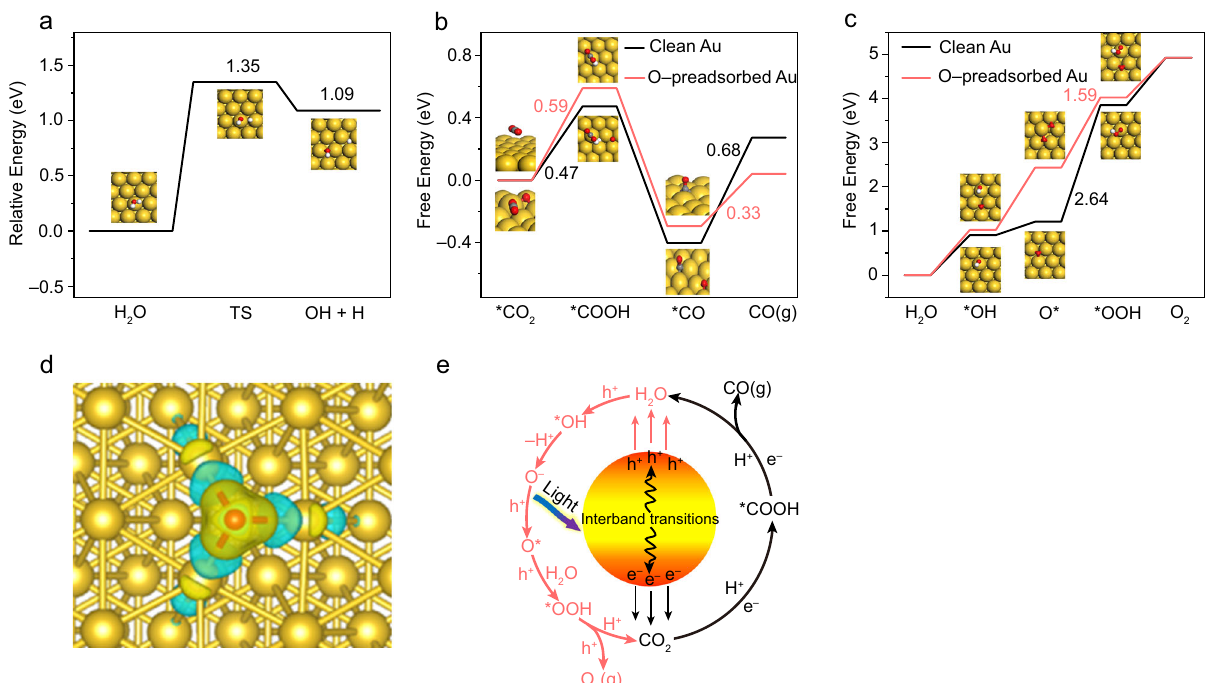
Fig. 5 DFT simulation results and catalytic mechanism. a The potential energy curves for H 2 O dissociation on Au without light irradiation. Free energy diagram for b CO 2 RR and c H 2 O oxidation on O pre-adsorbed Au and clean Au. The golden, red, and white balls represent Au, O, and H atoms, respectively. d Calculated charge density differences for O pre-adsorbed Au surface. The charge accumulation and depletion are colored in yellow and cyan. e Reaction pathways for the photoreduction CO 2 RR with H 2 O into CO and O 2 on the Au